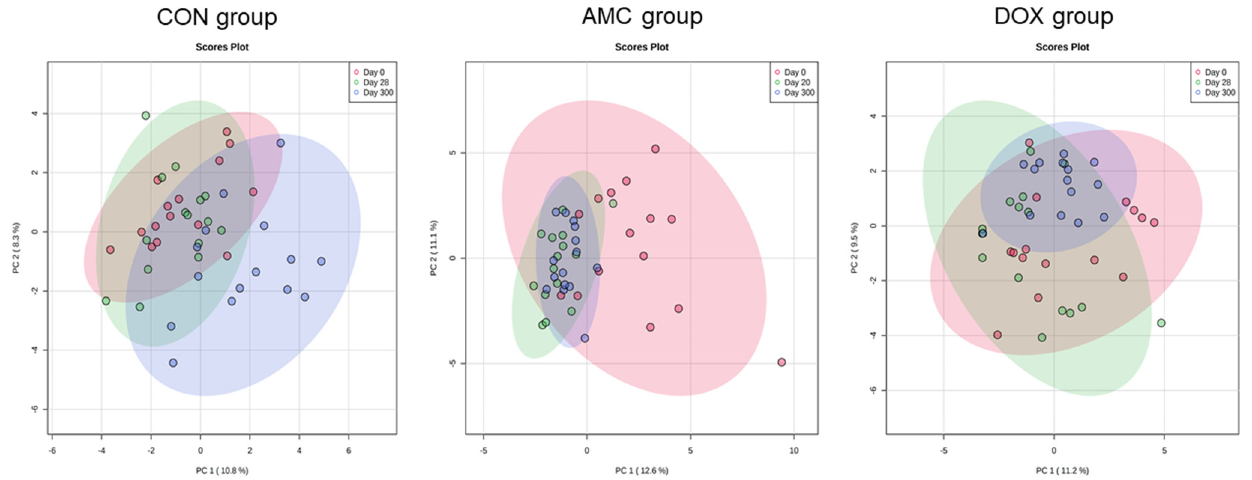
Figure 2. Principal coordinate analysis of serum metabolites for CON, AMC, and DOX groups on days 0, 20/28, and 300. Table 3. Peak heights of serum metabolites that significantly differed over time in cats of the AMC